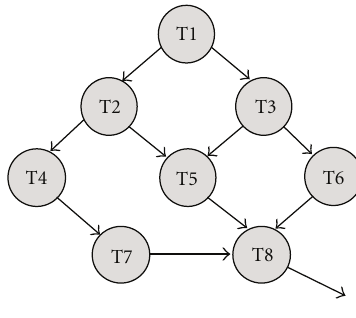
Figure 24: Dummy task